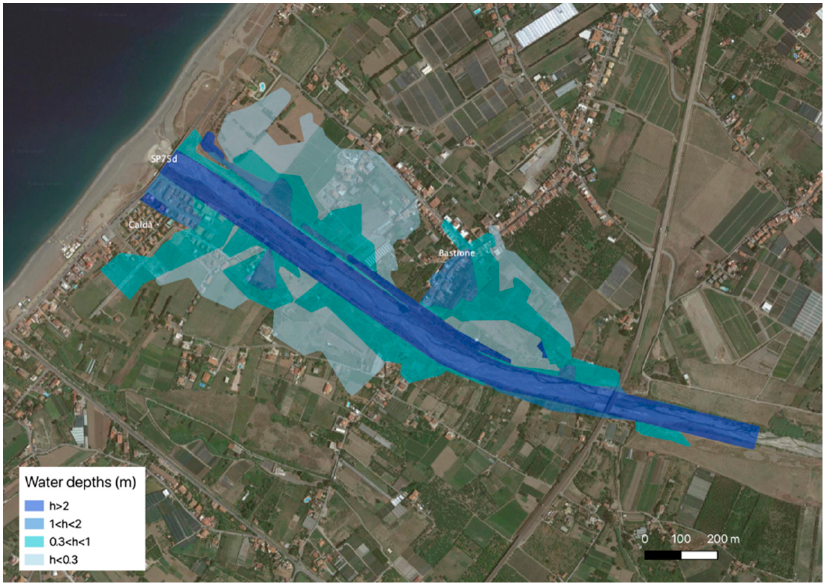
Figure 8. Inundation map for return time T = 100 years for different water depths (no intervention scenario).